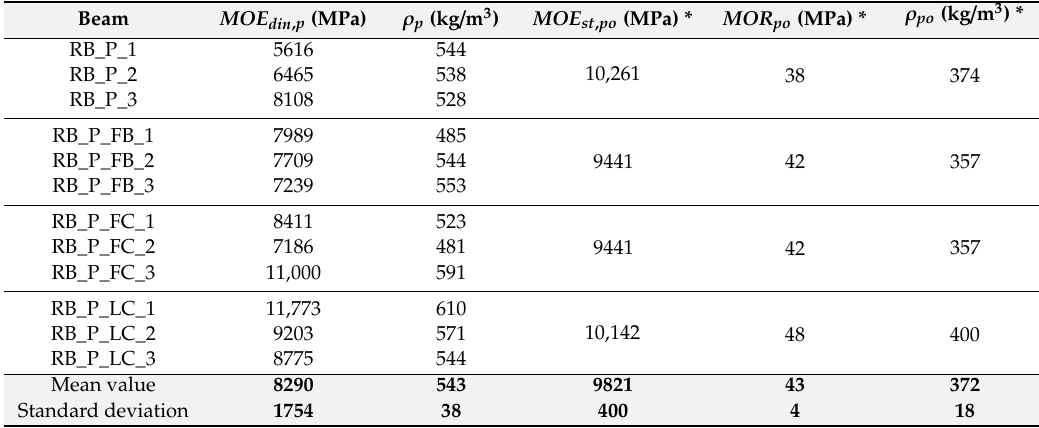
Table 1. Mechanical properties of pine beams and poplar